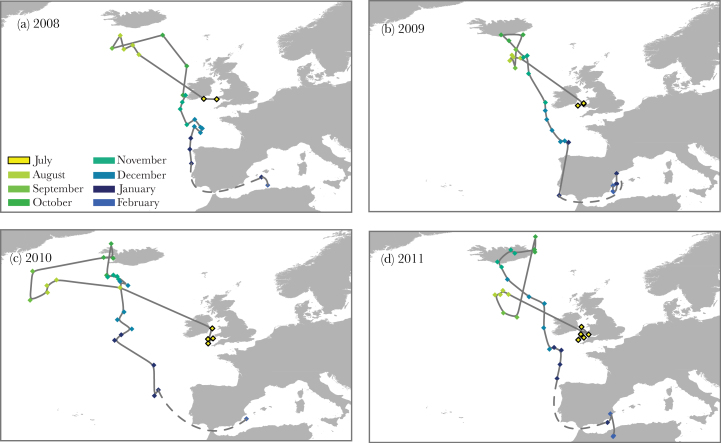
An example of spatial and temporal route fidelity during migration over 4 years. Routes shown are from a puffin tracked between 2007 and 2012. (a–d) Each position represents a 1-week median, each color represents a month. The continuous lines link the positions, the dashed lines are the probable trajectories of the bird through the Strait of Gibraltar (a straight line crossing across Spain is unlikely, as well as the crossing of Ireland). The points on land are due to low resolution of the data (~185 km) rather than actual positions on land.